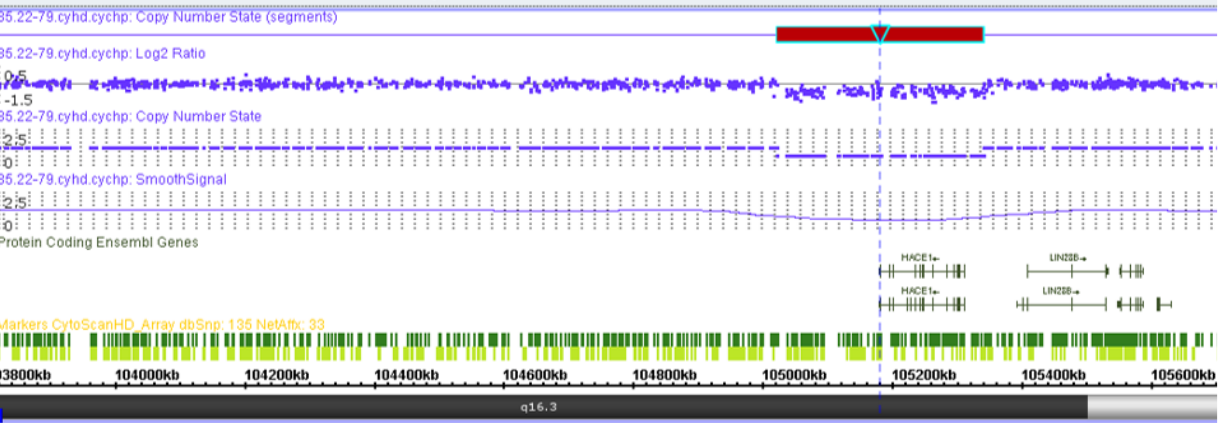
Figure 7. Visualization of the heterozygous deletion of the entire HACE1 gene in the patient by means of chromosomal microarray analysis.